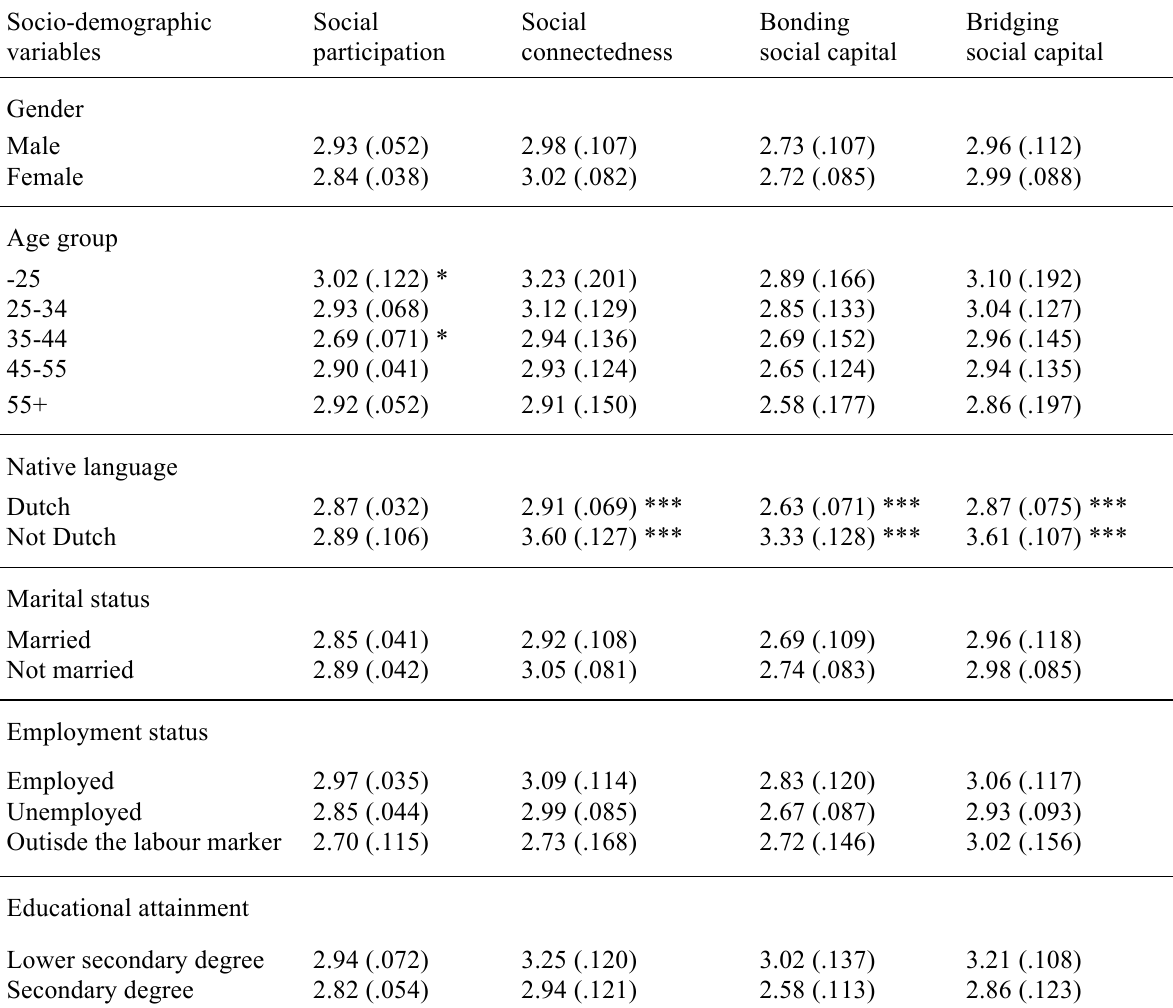
Table 5 : Group means (SE) among FEA online adult